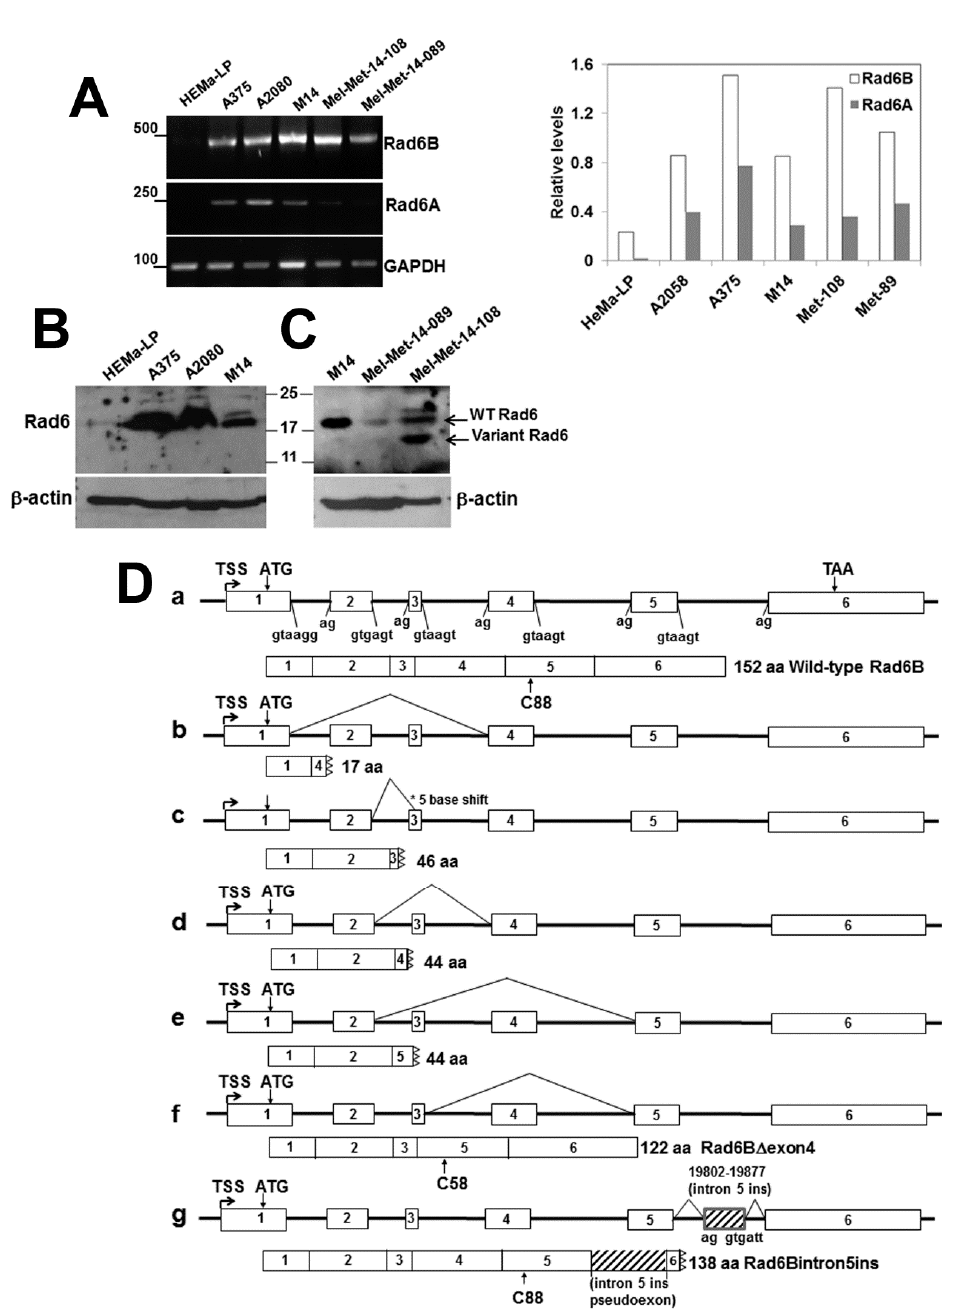
Figure 2. RAD6B is robustly expressed in melanoma lines and shows abnormal processing of transcript splicing. ( A ) RT-PCR analysis of RAD6A and RAD6B in normal (HeMa-LP) melanocytes, melanoma cell lines and clinical melanoma brain metastasis samples Mel-Met-14-108 and Mel-Met-14-089. RAD6A and RAD6B levels normalized to GAPDH are shown in the graph on the right. ( B ) and ( C ), Western blot analysis of RAD6 in HeMa-LP, melanoma lines and clinical melanomas. Note that since the RAD6 antibody does not distinguish RAD6A and RAD6B, the protein is indicated as RAD6. The presence of a 14 kDa variant RAD6 protein in clinical melanoma is indicated. ( D ) ( a ) Schematic structure of the human RAD6B gene and splice junctions. The wild-type protein with the active cysteine (C)88 is indicated below. ( b – g ) Schematic mutations of RAD6B splicing mutations identified in melanoma lines and clinical melanoma brain metastases. The 122 amino acid RAD6B Δ exon4 mutant ( f ) was identified in M14 and A2058 melanoma lines, and the 138 amino acid RAD6Bintron5ins ( g ) splice mutant was identified in the M14 line. The positions of the active cysteine residue in the splice mutants are shown.